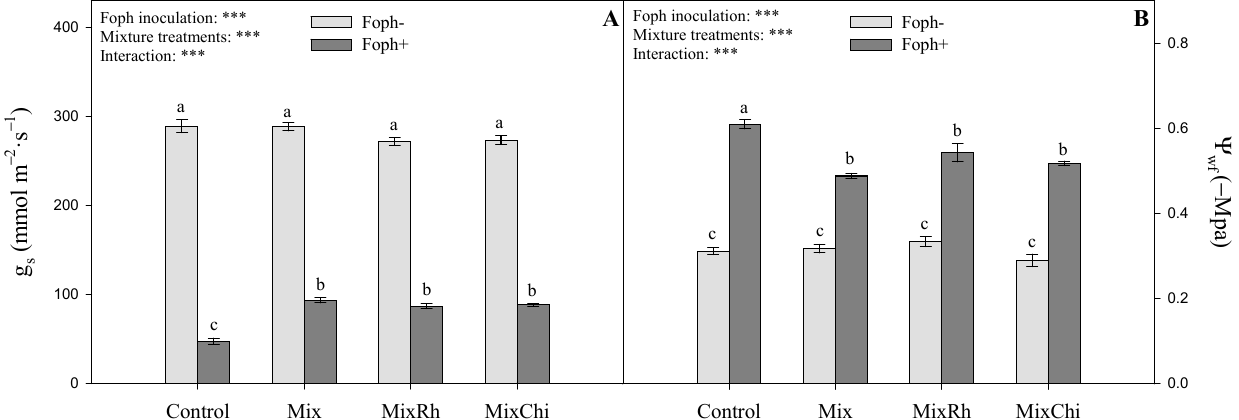
Figure 3. Effect of treatments with mixtures of biological control agents and organic additives (Mix ( T. virens + B. velezensis ), MixRh ( T. virens + B. velezensis + burnt rice husk) and MixChi ( T. virens + B. velezensis + chitosan) on ( A ) stomatal conductance (g s ) and ( B ) leaf water potential ( Ψ wf ) of cape gooseberry seedlings without (light grey bars) and with (dark grey bars) F. oxysporum f. sp. physali (Foph) inoculation at 50 days after inoculation (DAI). Error bars represent the mean of four values ± standard error. Significant differences between treatments are indicated by different letters according to the Tukey’s test ( p ≤ 0.05). *** p < 0.001—values of the ANOVA of Foph inoculation, mixture treatments, and their interaction.